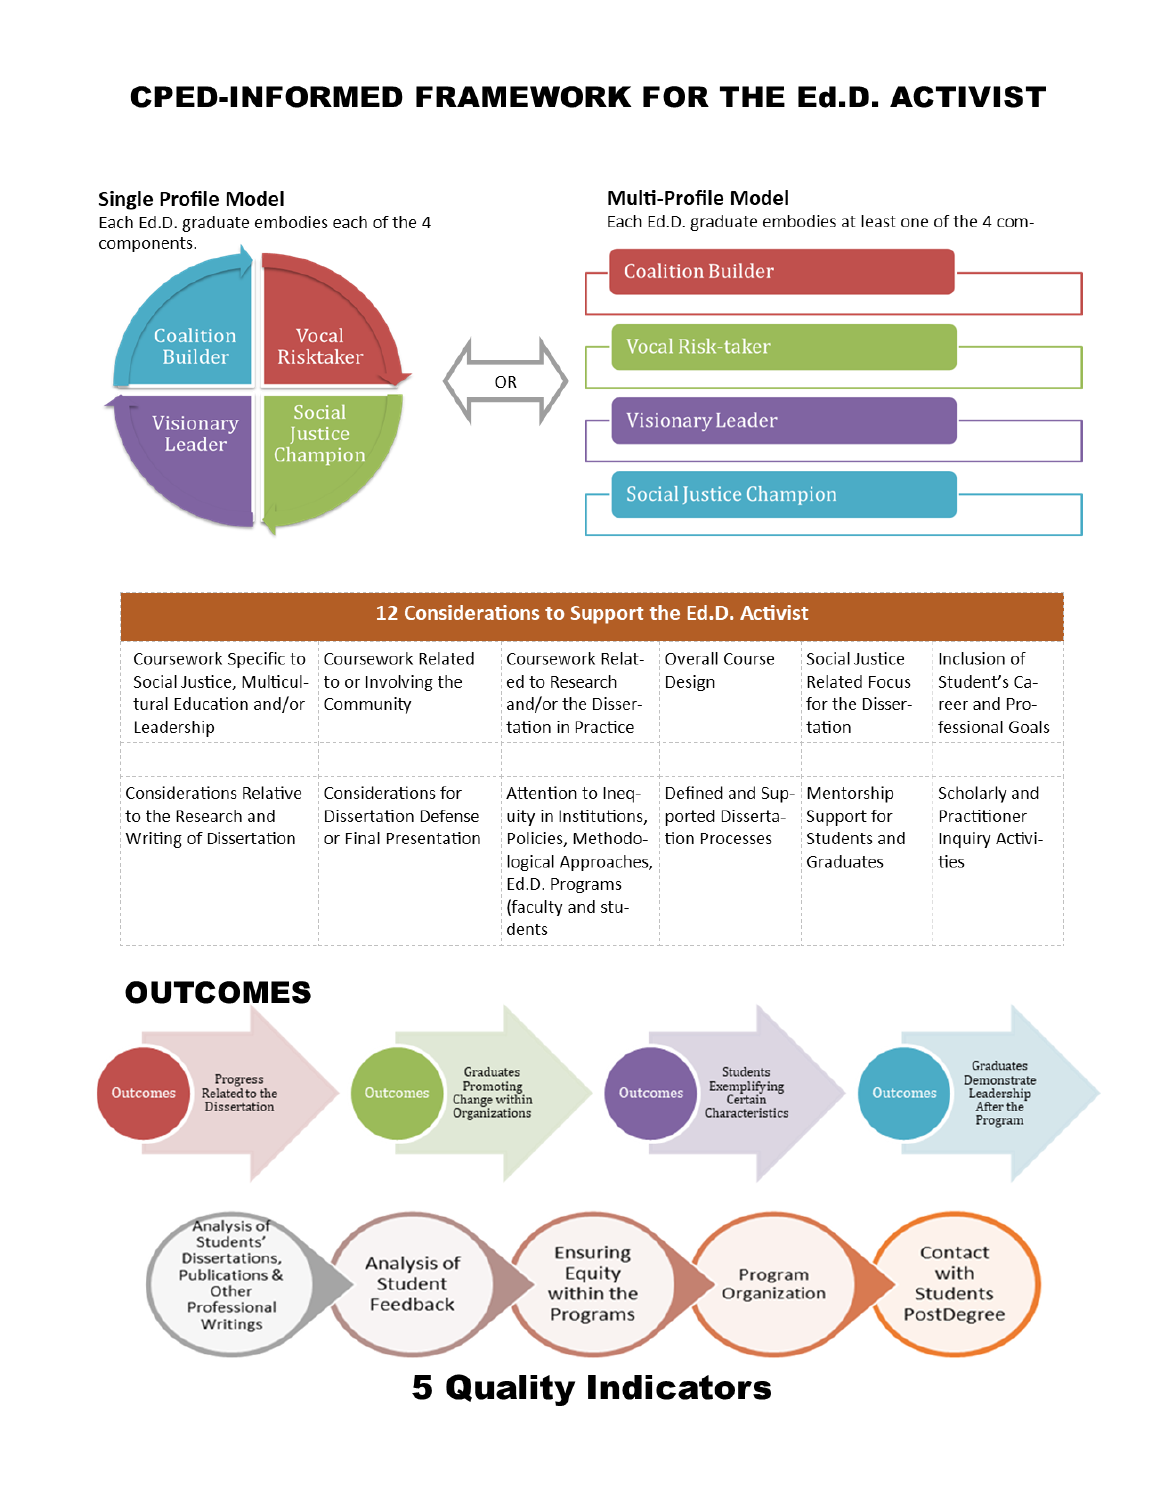
Figure 3. CPED-Informed Framework for the Ed.D.